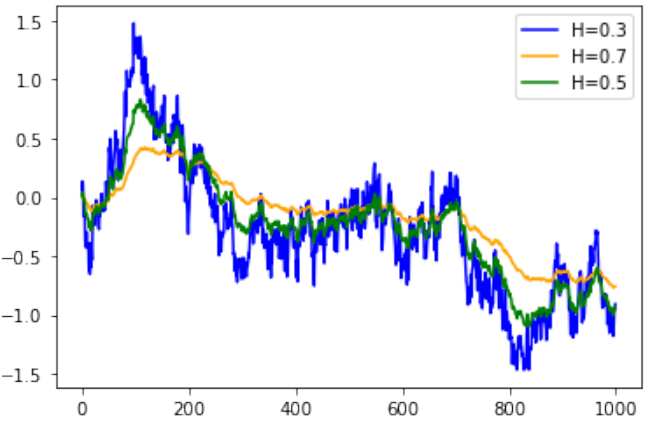
Figure 1. Simulated fBm paths with H = 0.7,0.5, and